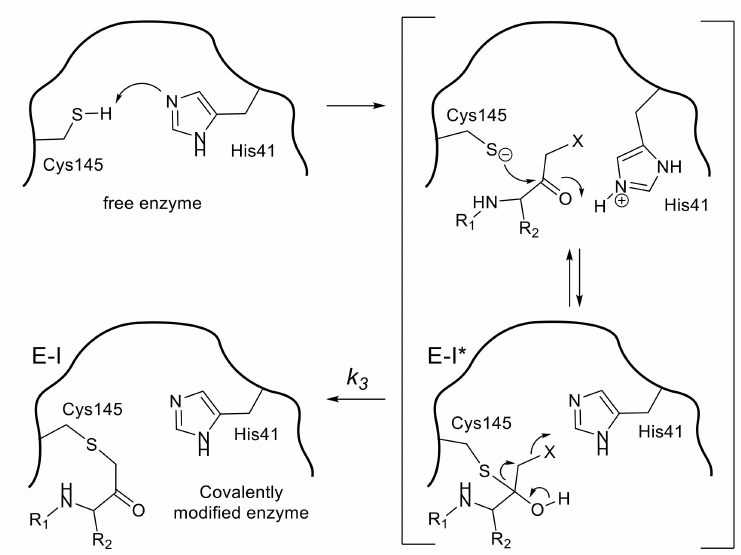
Figure 4. A possible mechanism for the inactivation by a halomethyl ketone